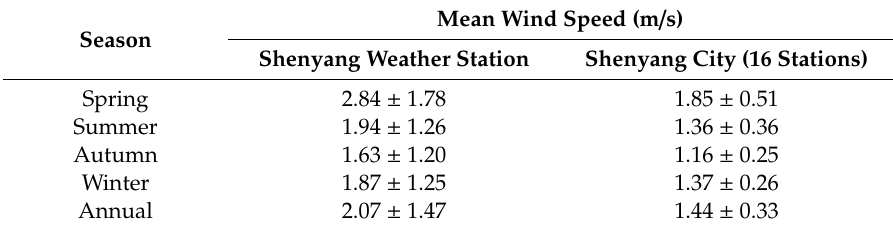
Table 3. Annual and seasonal mean wind speed at Shenyang weather station and the 16 stations with standard deviations